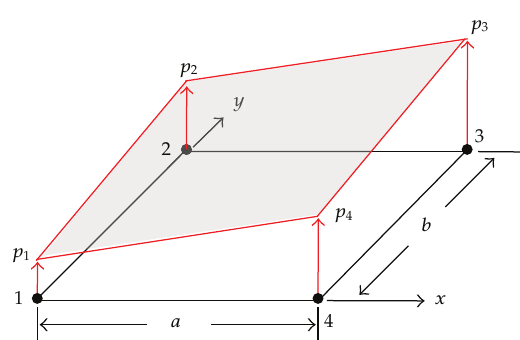
Figure 3: Non-uniformly distributed lateral pressure loads in a plate